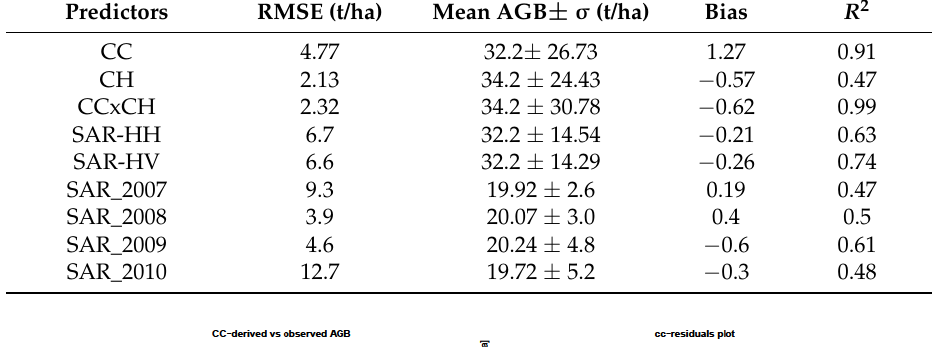
Table 4. TLS and microwave AGB predictor variables and associated error and coefficient of determination ( R 2 ).